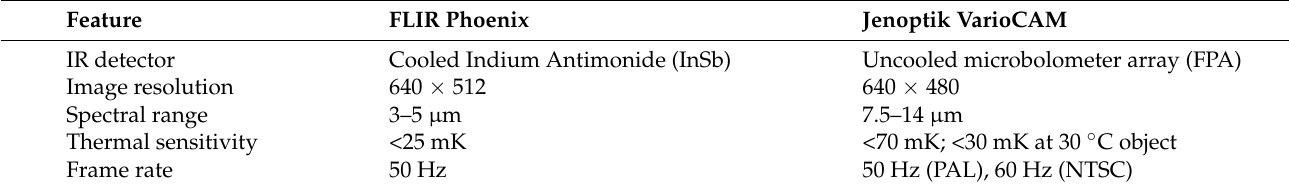
Figure 1. The experiment setup overview. Table 1. Thermal camera